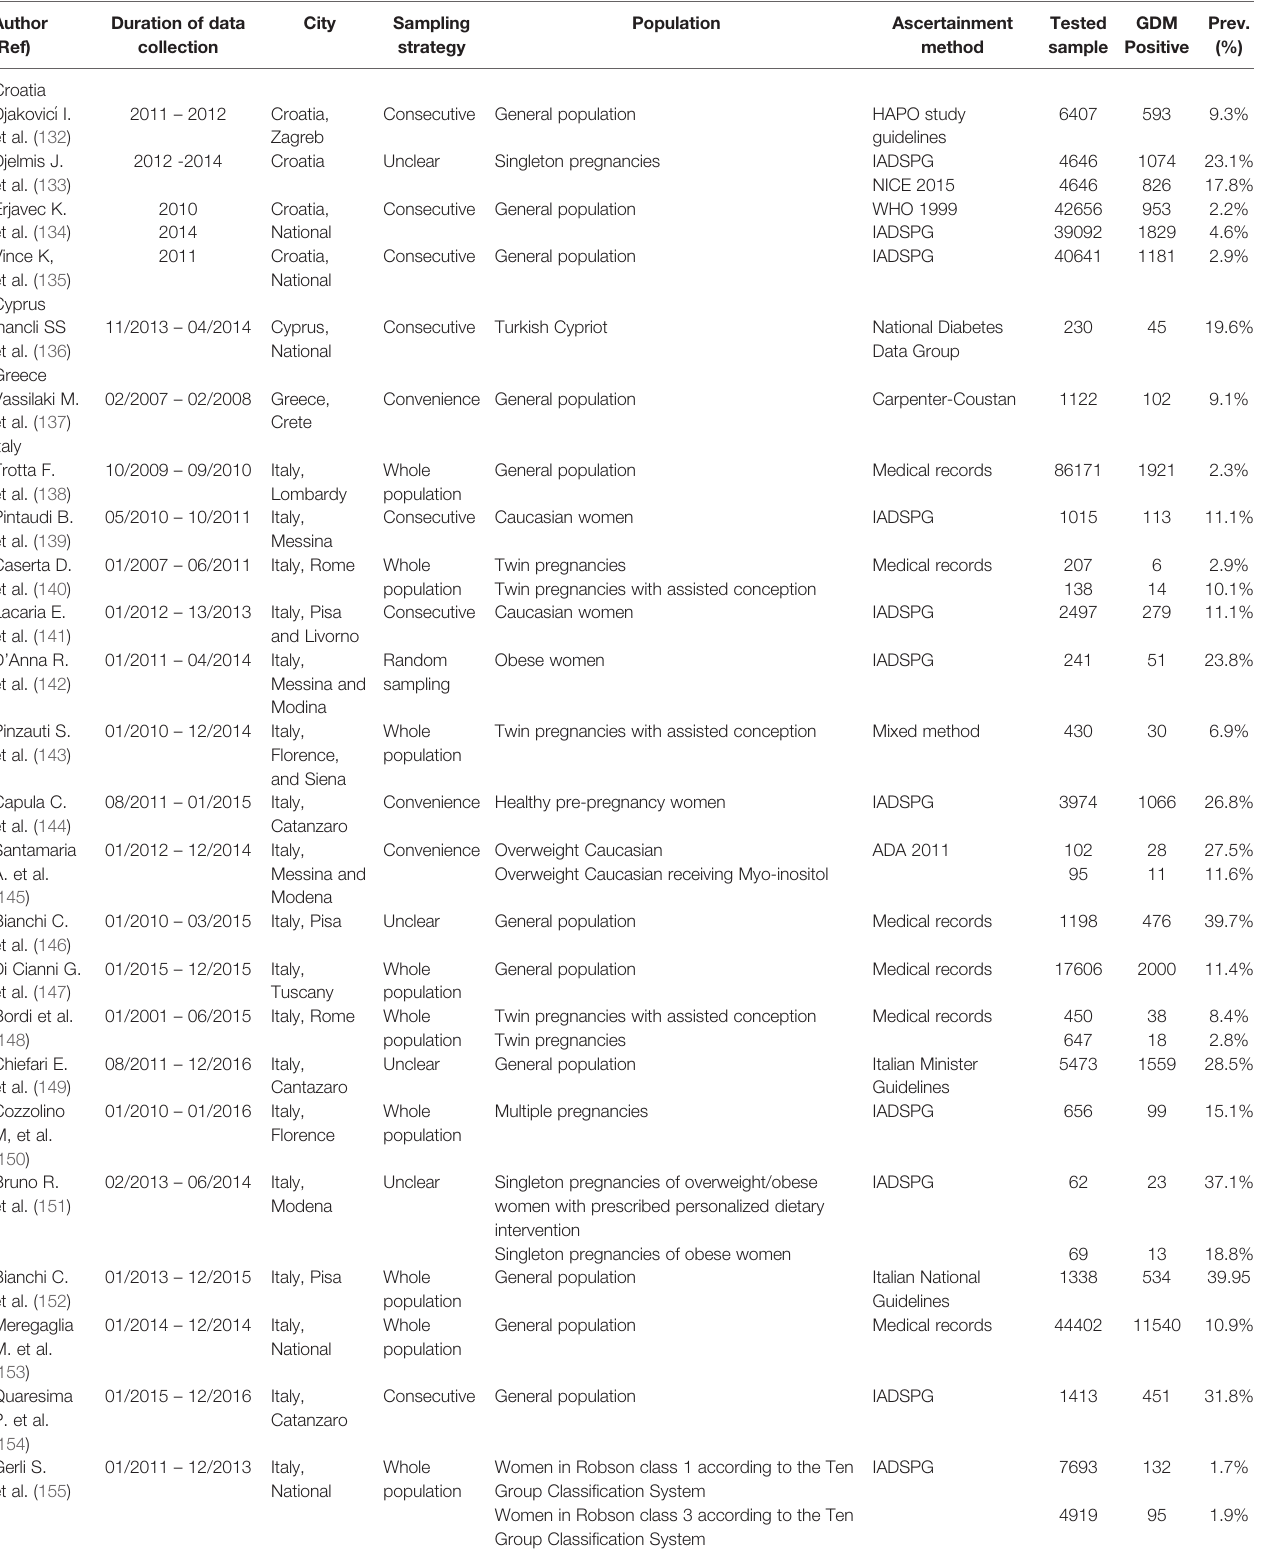
TABLE 4 | Baseline studies characteristics from Southern